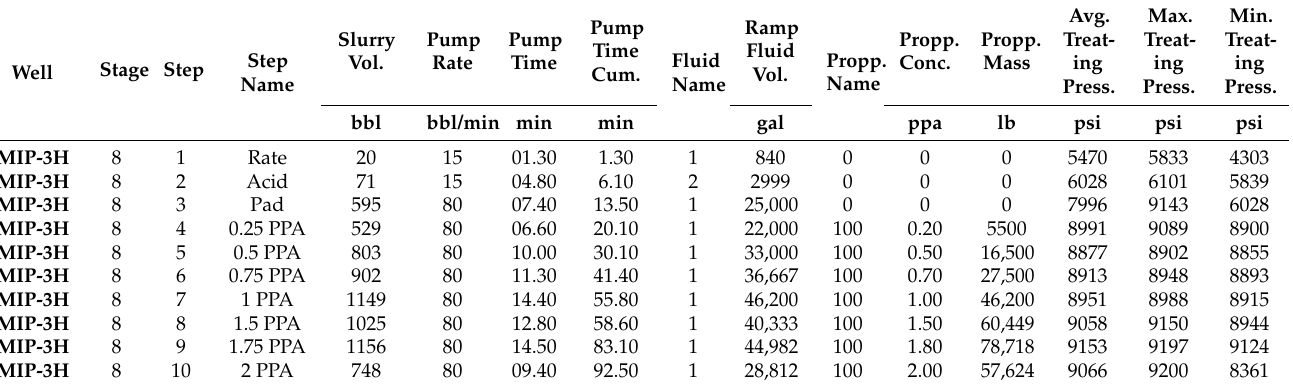
Table 1. Input table generated from MSEEL stimulation reports.